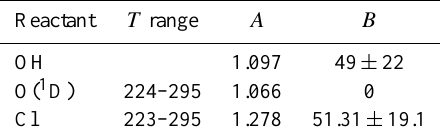
Table 1. Temperature-dependent kinetic isotope fractionation coef- ficients for the reaction with CH 3 D. The kinetic isotope effect is determined by KIE (T ) = A · exp (B/T ) for the given temperature range (see Röckmann et al.,